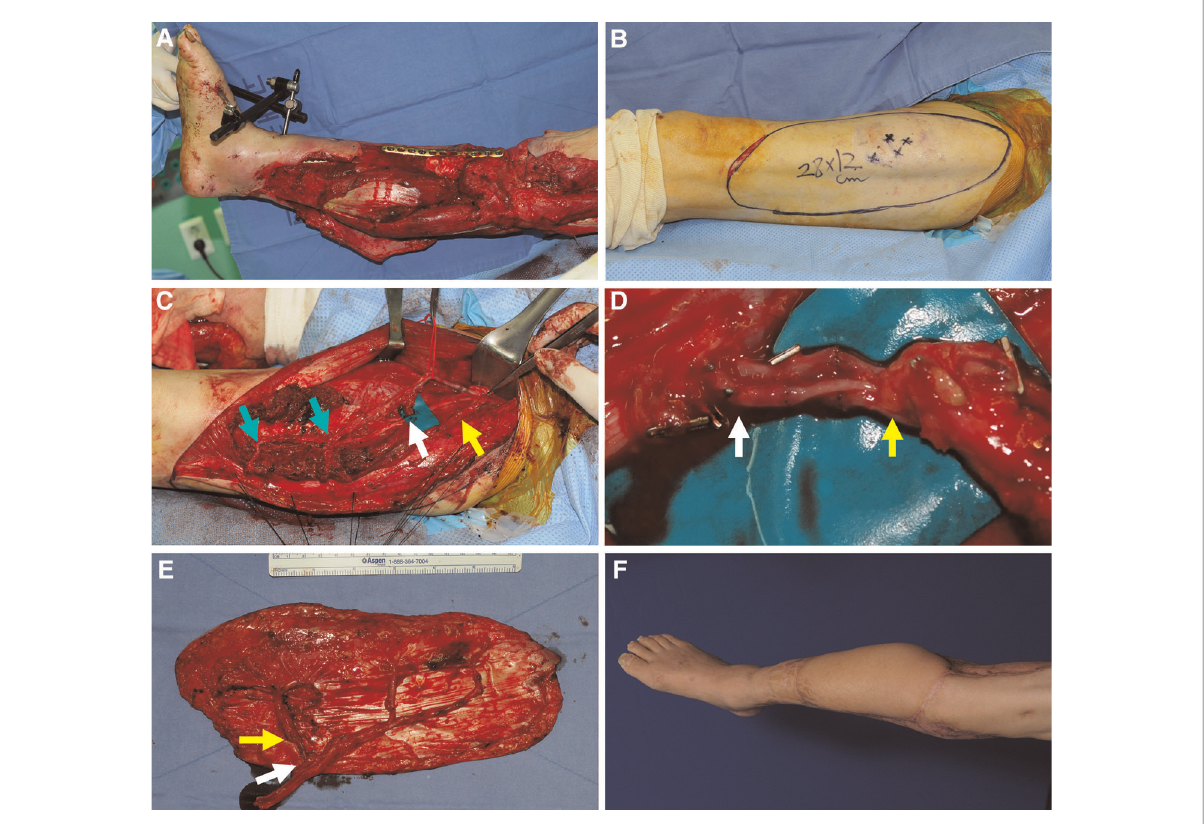
FIGURE 6 A clinical case showing reconstruction with a wide ALTP fl ap where the turbocharging procedure was performed before harvesting the fl ap. (Each arrow indicates as follows: yellow indicates a perforator from TB-LCFA; green indicates DB-LCFA; white indicates side branches of DB-LCFA). ( A ) A 73-year-old man presented with extensive soft tissue defects on the right lower leg caused by a traf fi c accident. ( B ) A wide ALTP fl ap (28×12 cm 2 ) was elevated to cover exposed bone and plate after radical debridement and temporary bony fi xation. ( C ) The ALTP fl ap included perforators from both DB-LCFA and TB-LCFA, and all vessels related to the turbocharging procedure were isolated and prepared. ( D ) The anastomosis was executed. ( E ) The harvested turbocharged wide ALTP fl ap ( F ) 16 months postoperatively. ALTP, anterolateral thigh perforator; TB-LCFA, transverse branch of lateral circum fl ex femoral artery; DB-LCFA, descending branch of lateral circum fl ex femoral